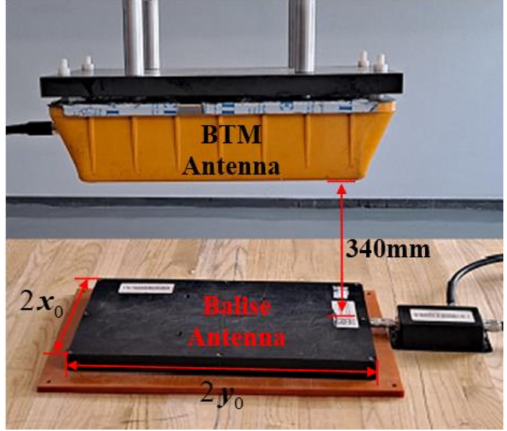
Figure 12. Tele-powering field conformity test configuration.